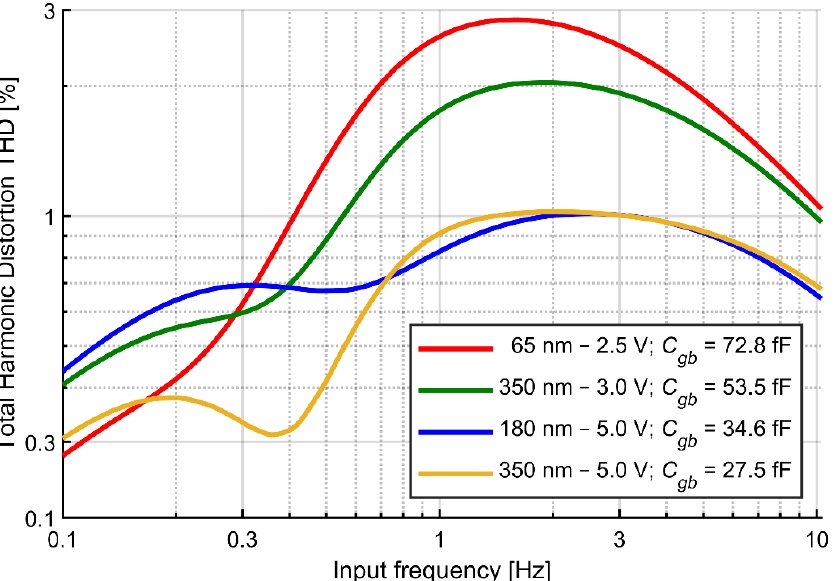
Figure 6. Simulated THD versus signal frequency for the fixed- V gs circuit for different technologies. Signal amplitude: 10 mV pp . V gs values were tuned for each simulation to get the same cutoff frequency (1 Hz).